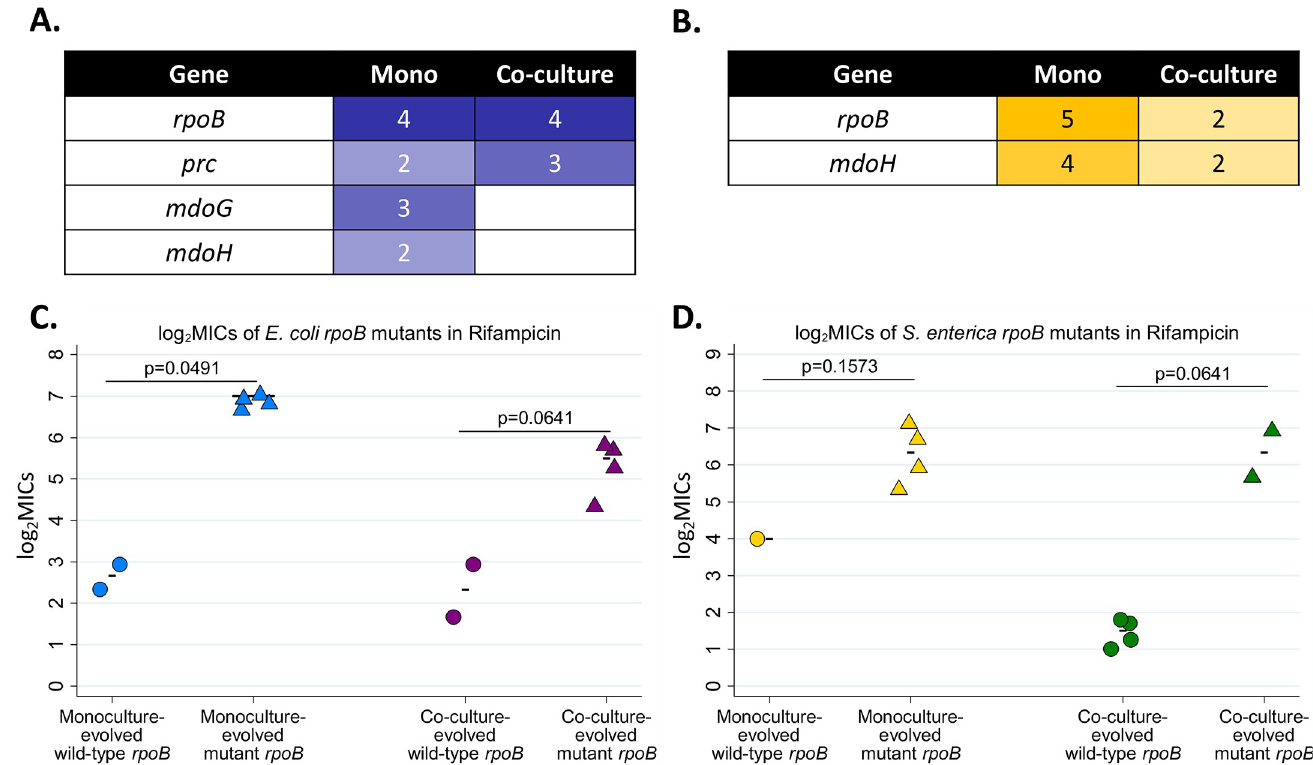
Fig 3. Resistance-associated mutations in rifampicin-resistant evolved populations A-B. Lists of mutations which arose in E . coli ( A ) or S . enterica ( B ) monocultures and co-cultures. The number in each box represents the number of independent replicates in which the putative resistance mutation was observed. Additional mutations that occurred in only one population, and details on the nature of these mutations, may be found in S1 Table . C-D. Rifampicin MICs for isolates with wild-type vs. mutant rpoB genes in E . coli ( C ) and S . enterica ( D ). Isolates were obtained from passage 20 populations by streaking onto selective medium and picking isolated colonies. Each data point represents the average MIC for three isolates obtained from a single population. For each species- culture type combination, there are six populations total, and the statistical comparisons represent MIC comparisons between populations with wild type vs. mutant alleles. Note that there are only five S . enterica monoculture populations due to possible contamination in one population. MIC 90 values for isolates were defined as the lowest concentration of antibiotic which decreased growth by greater than 90% by 48 hours at 30˚C. Additionally, monoculture lines evolved more mutations than co-culture lines. Mutations in mdoG and mdoH were observed in both monocultures of E . coli and S . enterica under rifampicin selection, but at much lower frequencies in co-culture ( S1 Table, S2 Fig ). All but one of these mutations were insertions or deletions of 1-6bp causing frameshift mutations ( S1 Table). Both mdoG and mdoH likely influence cell membrane permeability [31,32].The mutations were not associated with any changes in monoculture or co-culture growth rates ( S3 Fig ). Taken together, the pattern of rifampicin resistance mutations suggests that populations were moving along the same evolutionary trajectory in monoculture and co-culture, but progressed further along that trajectory in